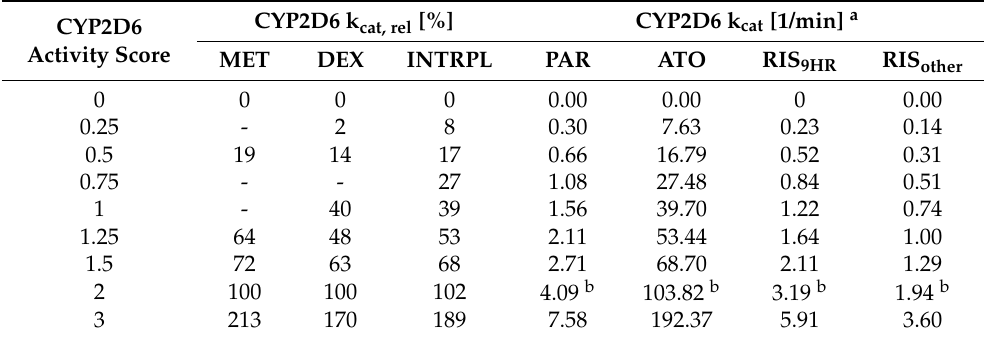
Table 2. OLS regression input values and interpolated k cat, rel values alongside model CYP2D6 k cat values for paroxetine, atomoxetine, and risperidone for different CYP2D6 activity